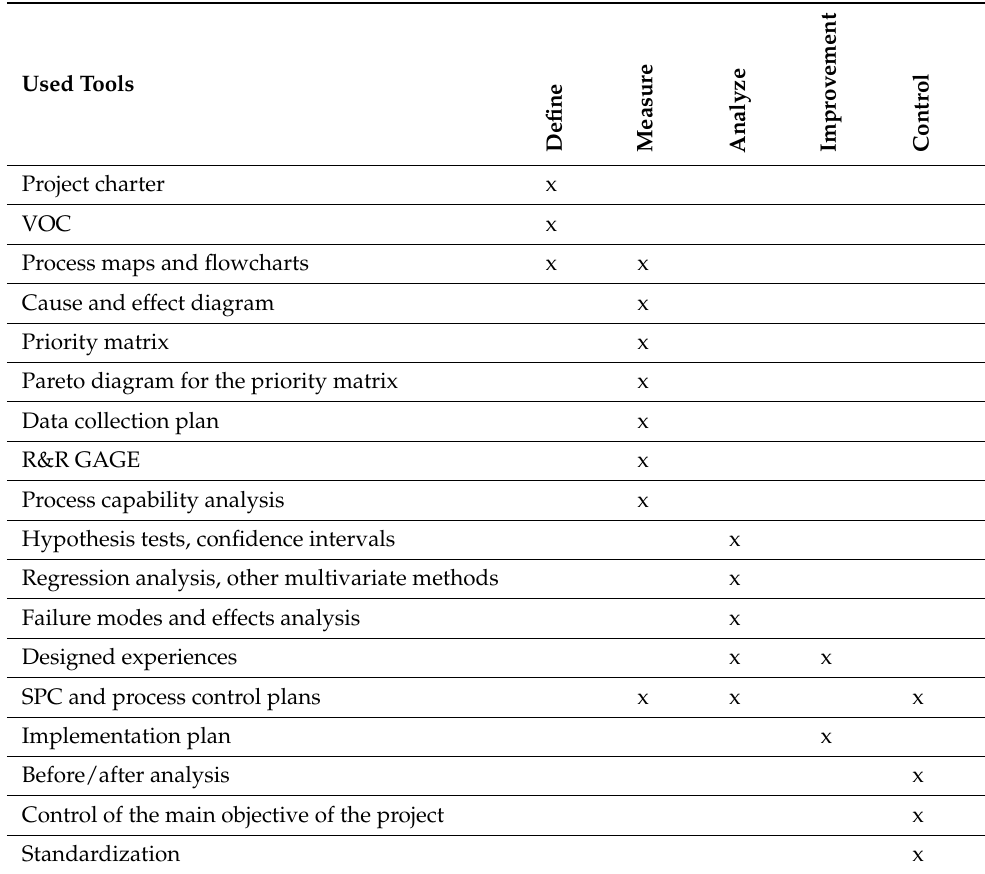
Table 1. Tools that were used in the Six Sigma steps.